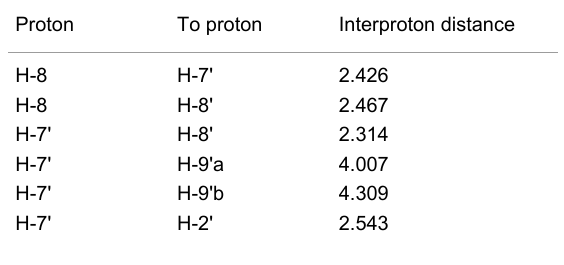
Table 3: Interproton distances (Å) for trogopterin C (compound 3 ) in the MM2-minimized